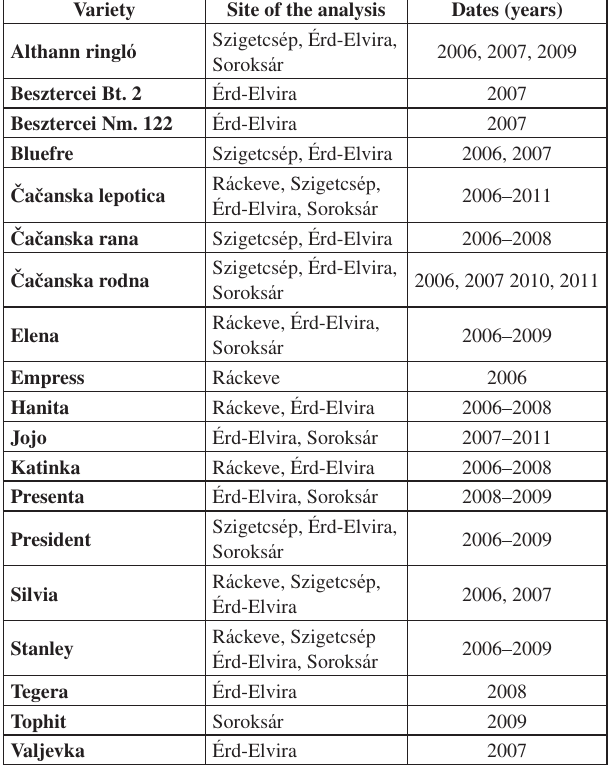
Table 1. Field observations, sampling sites and